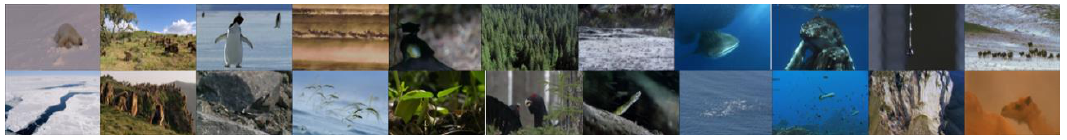
Figure 9. The representative frames of the BBC Planet Earth dataset.